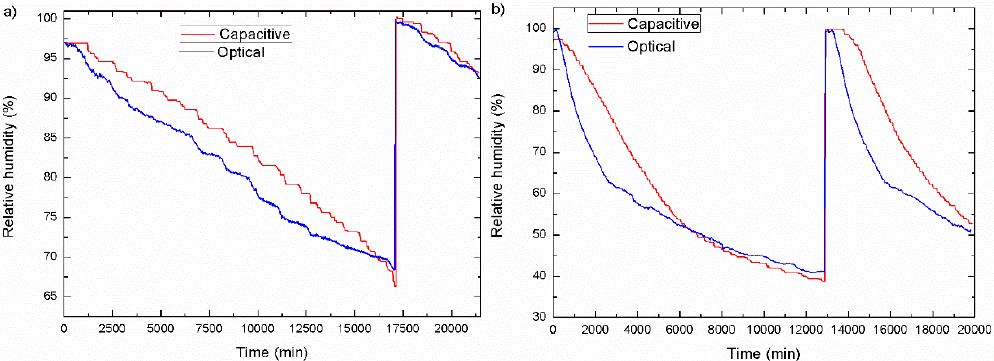
Figure 7. Capacitive and optical sensor’s response towards soil humidity: ( a ) Soil1 and ( b ) Soil2.